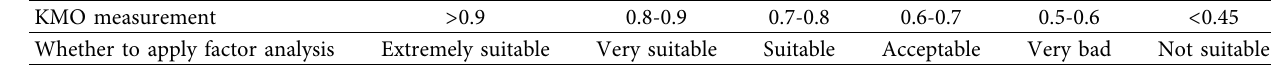
Table 3: KMO measurement statistics effect evaluation.